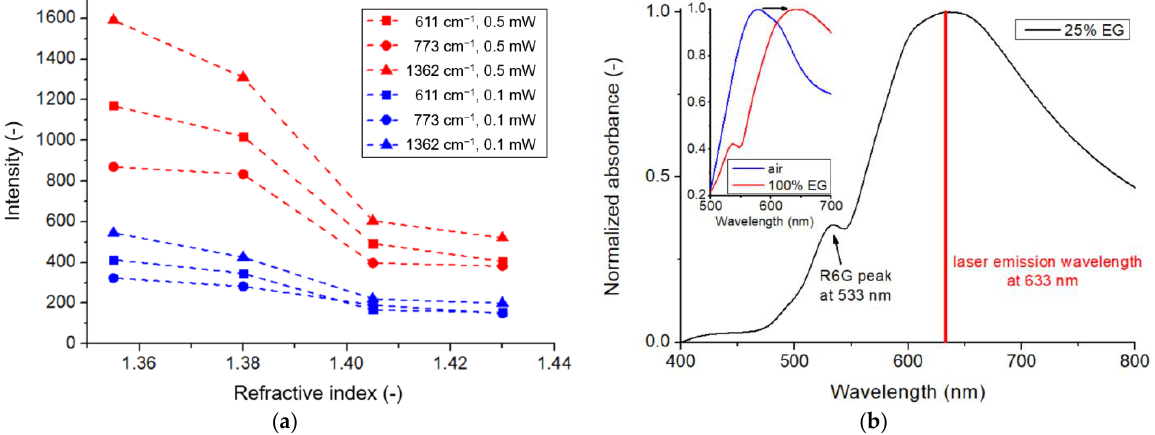
Figure 7. ( a ) Relative SERS intensities corresponding to characteristic peaks of the R6G molecules, measured at 633 nm excitation with 0.1 mW and 0.5 mW laser power, respectively. The data corre- spond with the spectra presented in Figure 5. ( b ) Normalized absorption spectrum of the type #2 substrate in 25% ethylene-glycol/water mixture, containing 1 × 10 −4 M R6G. The insert shows the shift between air ( n = 1) and 100% EG ( n = 1.4306).